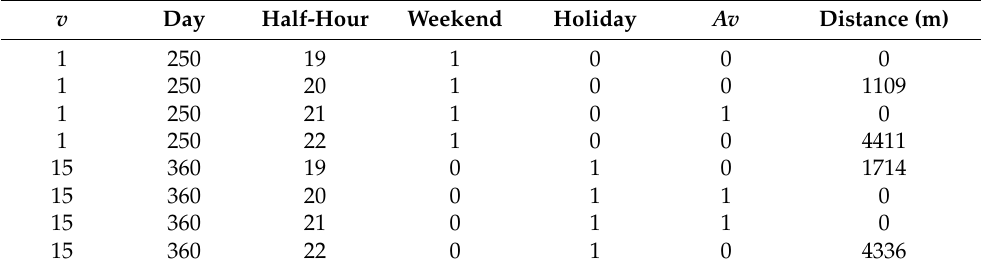
Table 2. Vehicle availability dataset for the trips shown in Table 1, where Av is the availability of vehicle v and distance is the total number of metres for trips completed in that period.